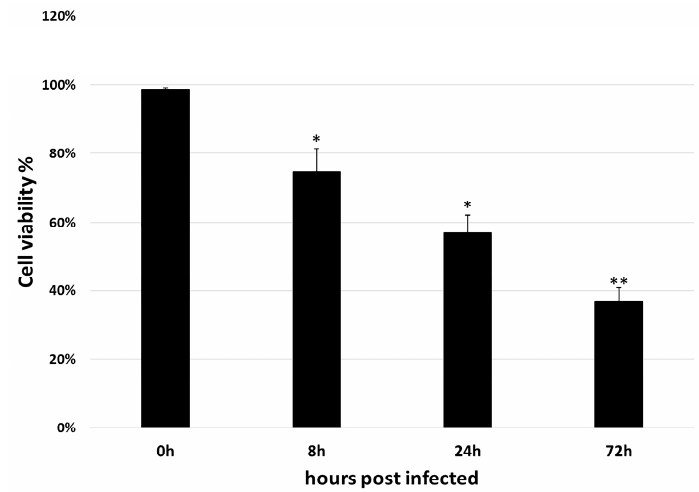
Figure 2. Cell viability assay after infected with GCRV. After 0, 8, 24 and 72 h post infection, cells were evaluated using CCK-8 assay, respectively. The mean of three replicates was shown with the ± standard deviation (S.D.). Significant difference between the control and treated group was indicated with asterisks (*: p < 0.05; **: p < 0.01)